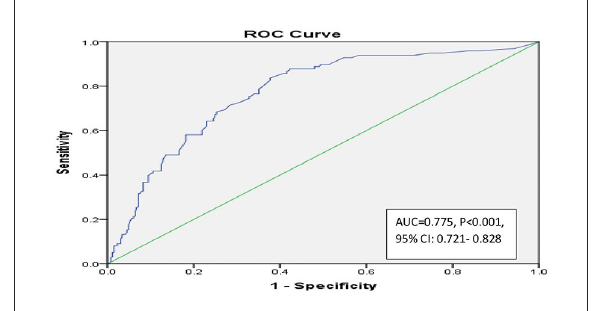
FIGURE2 Receiver operating characteristic (ROC) curve analysis of predictor for risk factors logistic regression model to predict prolong hospitalization of leptospirosis.